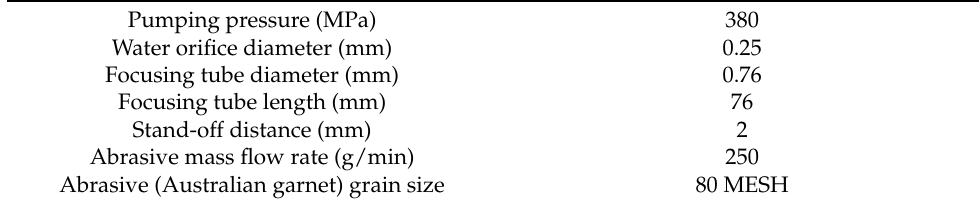
Table 1. Setup of basic experimental variables of AWJ (fixed variables).